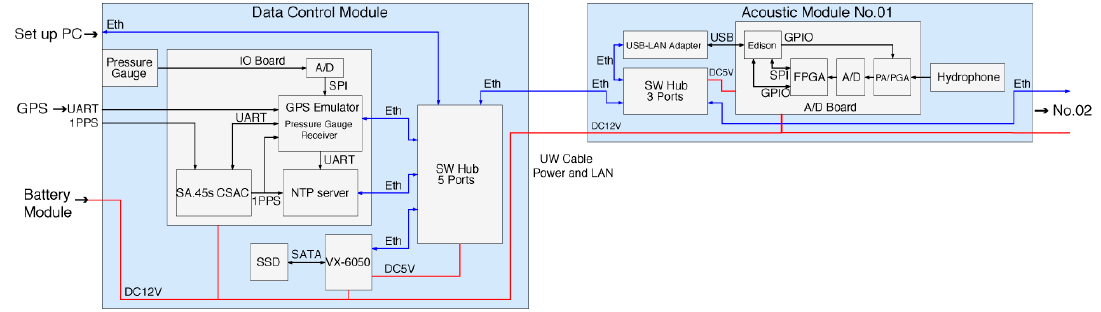
Figure 3. Block diagram of the main modules in this system. Eth: Ethernet, SW Hub: Switching Hub, UW: Under